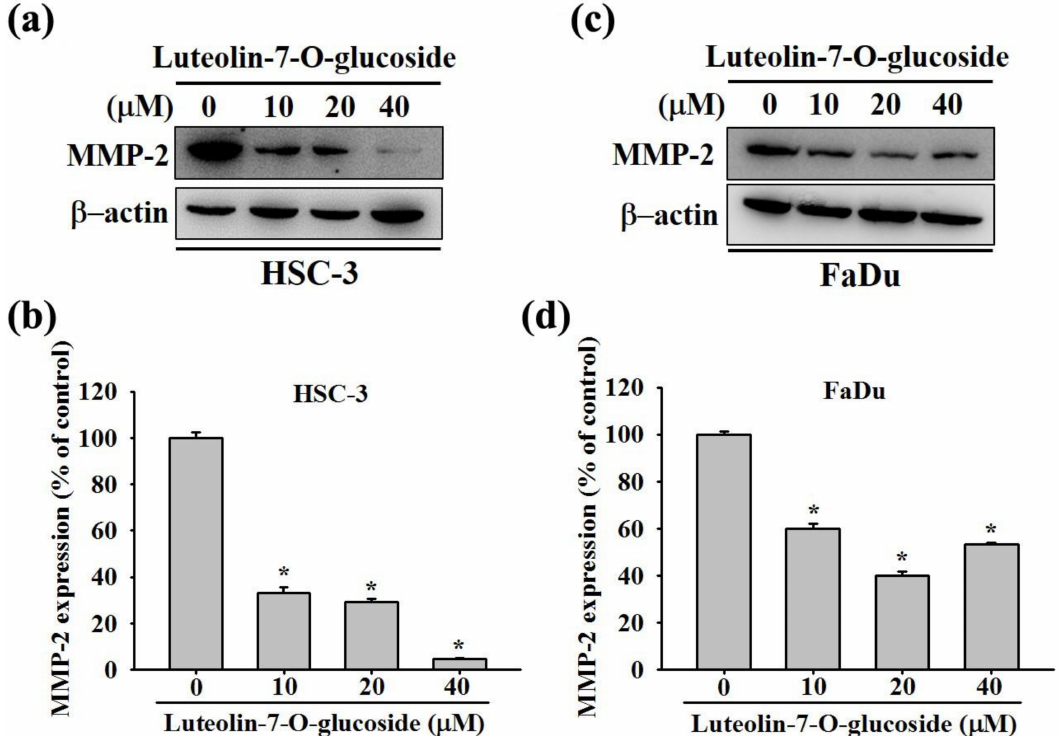
Figure 4. Luteolin-7-O-glucoside reduces the protein expression of matrix metalloproteinase (MMP)-2 in human oral cancer cells. The protein expression of MMP-2 was determined using Western blot in ( a ) HSC-3 and ( c ) FaDu cells. The quantitative results are shown in ( b ) and ( d ). The values are represented as mean ± SD of at least three independent experiments. * p < 0.05, compared with the control